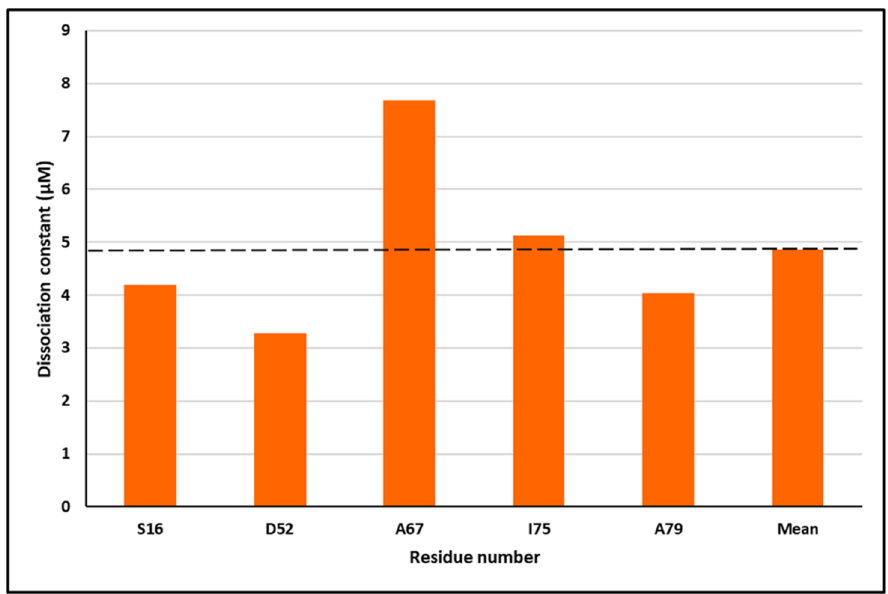
Figure 3. The dissociation constant (K d ) measured using the specified residues found in 15 N S100P titrations with unlabeled p53 1-73 , and the overall average K d was 4.86 μ M indicated with a broken line.